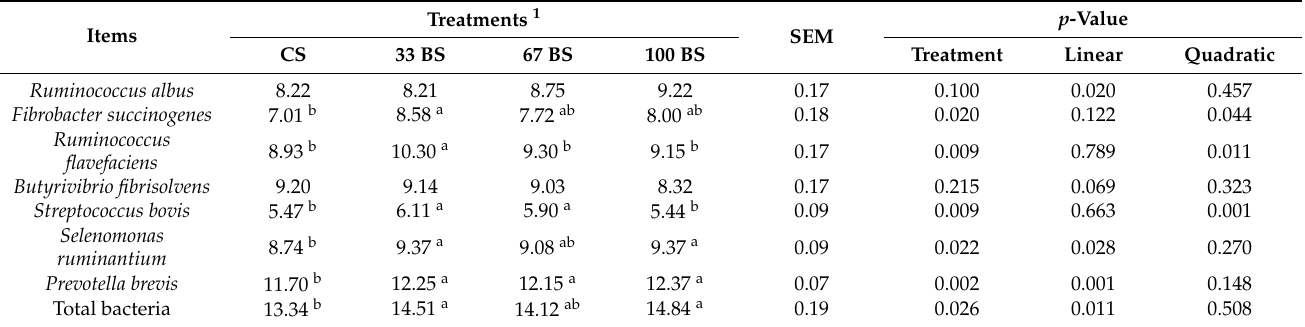
Table 7. Effects of dietary barley starch levels on the rumen microbial content at 2 h after morning feeding of Hu sheep (Log10 16S rRNA copy number/mL rumen